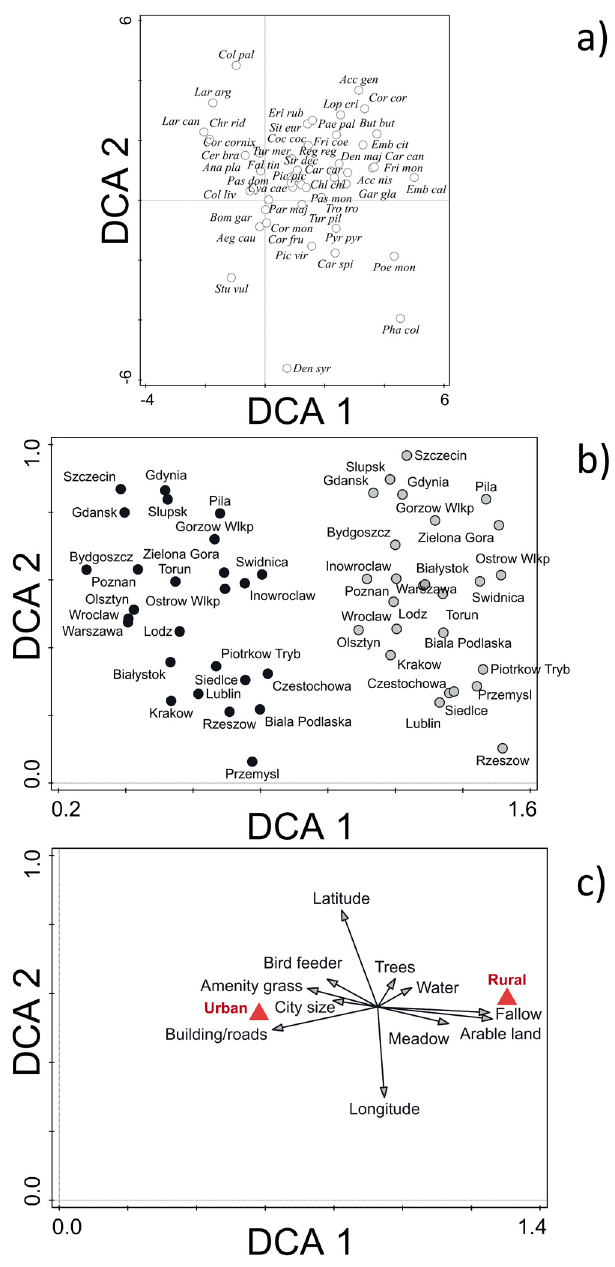
Fig 3. The DCA with environmental variables carried out on bird count data. The DCA with supplementary environmental variables carried out on the bird count data from Polish urban areas and paired rural areas. A. Species codes (Table 5) are shown for the 48 most common species; the remaining codes omitted and some jittering of codes has been done for clarity, B. The ordination of locations (grey symbol = rural, solid black symbol = urban), C. The ordination of supplementary environmental